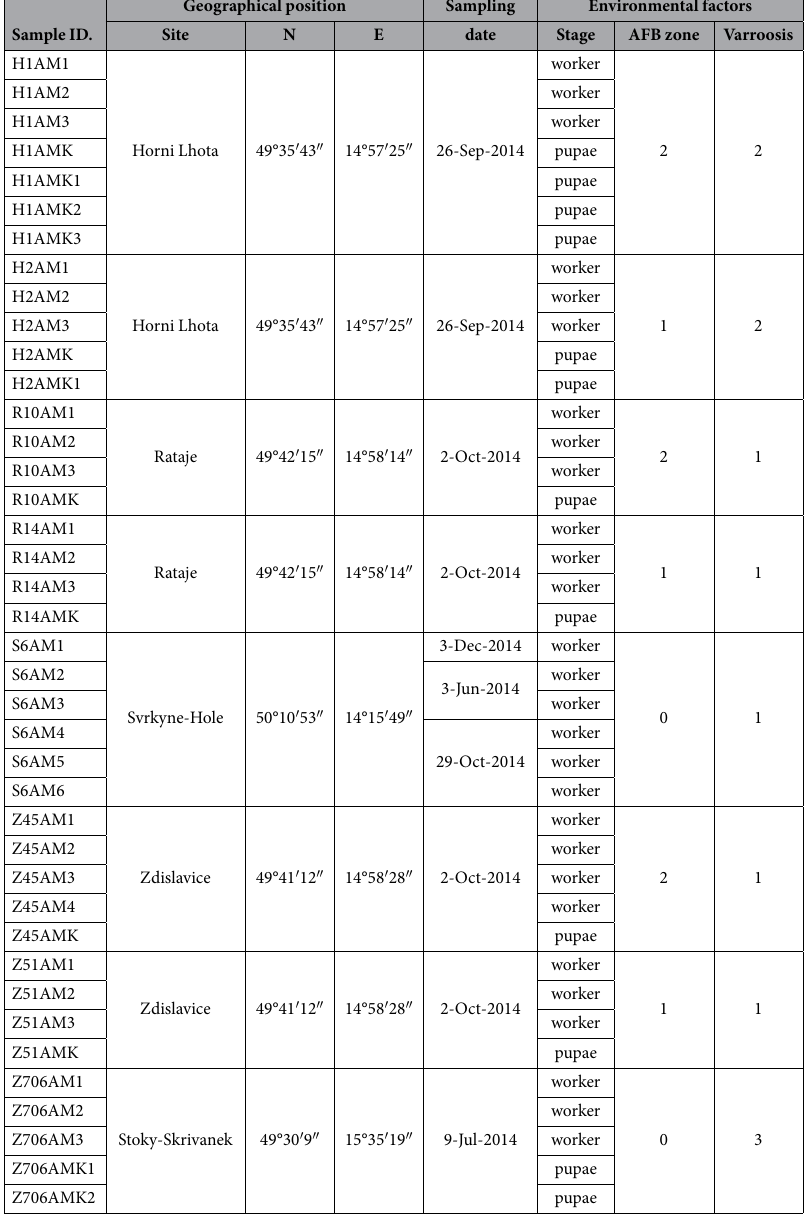
Table 3. List of honeybee colonies and apiaries sampled from June to December 2014 with sample descriptions and environmental variables including geographical position, sampling time, AFB status and the presence of varroosis. We coded AFB as follows: (i) AFB0, control: bees from colonies outside the AFB zone with no signs of AFB; (ii) AFB1: bees from asymptomatic colonies in AFB apiaries; and (iii) AFB2: bees from colonies exhibiting clinical symptoms of AFB. Varroosis quantification was based on the number of mites on the bottom boards of a hive: level 1: 0–50 mites, level 2: 51–100 mites, and level 3: 101 mites or